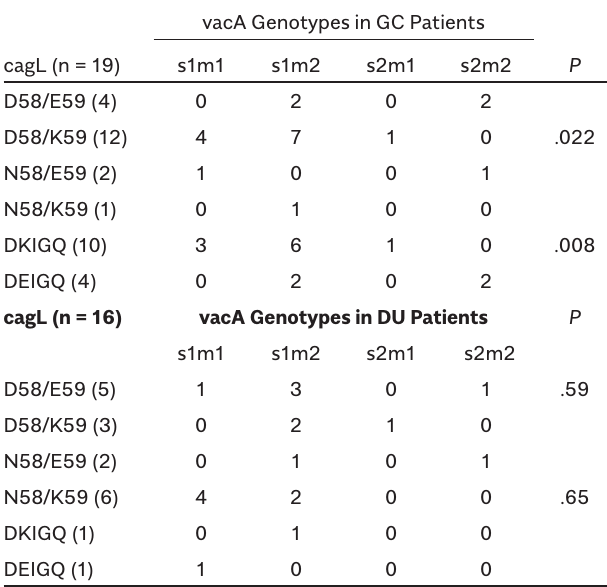
Table 5. Association between CagL Polymorphisms and vacA Genotypes H. pylori DNA Isolates in GC and DU